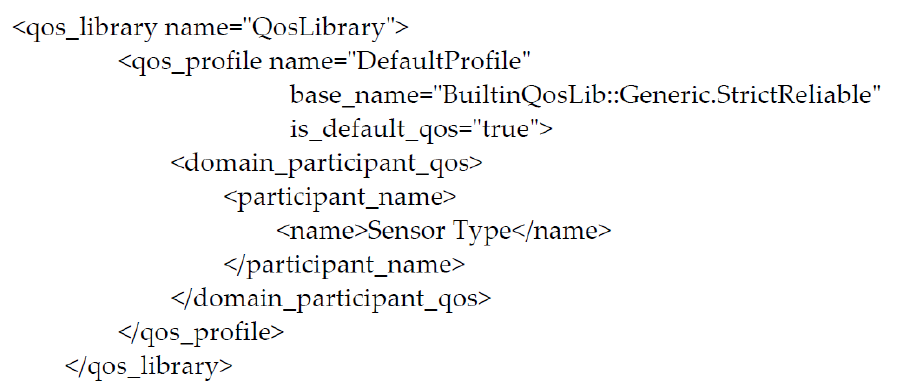
Figure 10. Sample QoS configuration of the proposed platform.